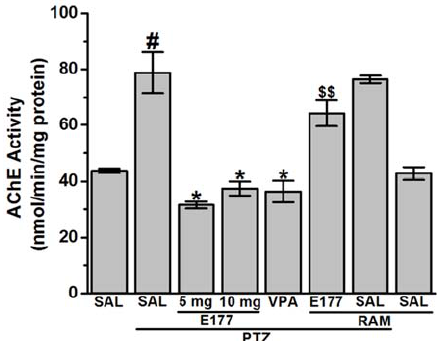
Figure 6. H3R antagonist E177 treatment restored elevated acetylcholine esterase activity levels in hippocampus of PTZ ‐ kindled rats. Levels of AChE were assessed in rat hippocampus. E177 (5 and 10 mg/kg; i.p.) and VPA (300 mg/kg, i.p.) were administered 30 ‐ 45 min prior each PTZ ‐ injection. Effects of systemic co ‐ injection with RAM (10 mg/kg, i.p.) on E177 (5 mg/kg) ‐ provided modulation on AChE levels were assessed. Data are expressed as the mean ± SEM ( n = 6). # P < 0.05 vs. saline ‐ treated rats. * P < 0.05 vs. PTZ ‐ kindled rats. $$ P < 0.001 vs. E177(5 mg) ‐ treated PTZ ‐ kindled rats.